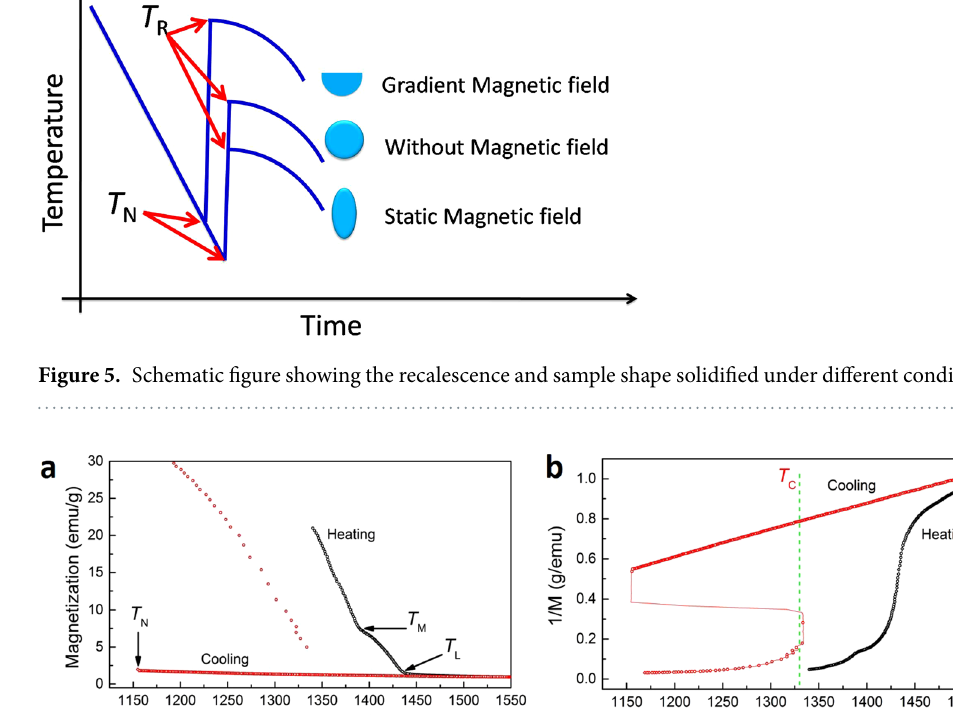
with with ellipticity (c/a) close to 0.7) have the same undercooling, but the latter has a much lower recalescence extent. Next we will discuss the factors that can cause these differences. Figure 6(a) is the magnetization as a function of temperature during heating and cooling process for Co 76 Sn 24 alloy in 93 T/m gradient magnetic field (the field intensity at the sample position is 6.23 T). During heating pro- cess, the magnetization will decrease with the increasing temperature. T M detected by magnetization curve is about 1385 K which is consistent with the melting point shown in Fig. 2(a). Above T L (1437 K), the alloy turns into fully liquid state and during the cooling process, the magnetization curves are overlapped for the data measured during heating. When the melt enters into the undercooled state, we do not see any kink point and the curve still follows the same trend and the discrepancy between the heating and cooling process becomes larger before the nucleation starts at T N = 1152 K: the magnetization of the undercooled liquid is much smaller than its solid state at the same temperature. The trend can be made clearer when we plot the inverse magnetization curve as a func- tion of the temperature (shown in Fig. 6(b)). The melt will be in paramagnetic state in case of the 1/M-T curve is linear according to the Curie-Weiss law. During heating process, the linear state initiates when the temperature is far above the melting point while during the cooling process, the whole curve is in the same slope before the nucleation happens. After solidification, two phases, ferromagnetic α Co and paramagnetic β Co 3 Sn 2 phase are formed in Co 76 Sn 24 near eutectic alloy. Compared to α Co, the magnetic Gibbs free energy of β Co 3 Sn 2 can be neglected due to its low magnetic susceptibility. In the present experiment, when Co 76 Sn 24 alloy is solidified at undercoolings shown in Fig. 3, the solid α Co phase will be in ferromagnetic state due to the temperature is blow the Curie point (even